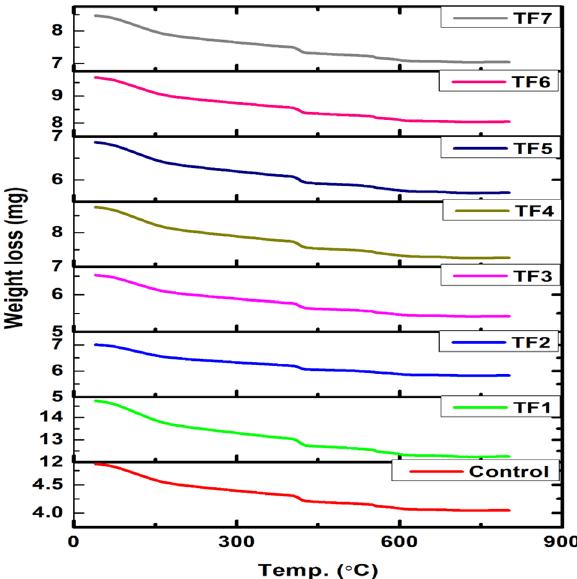
Figure 5. TGA analyses of Tuff samples at 60 days.